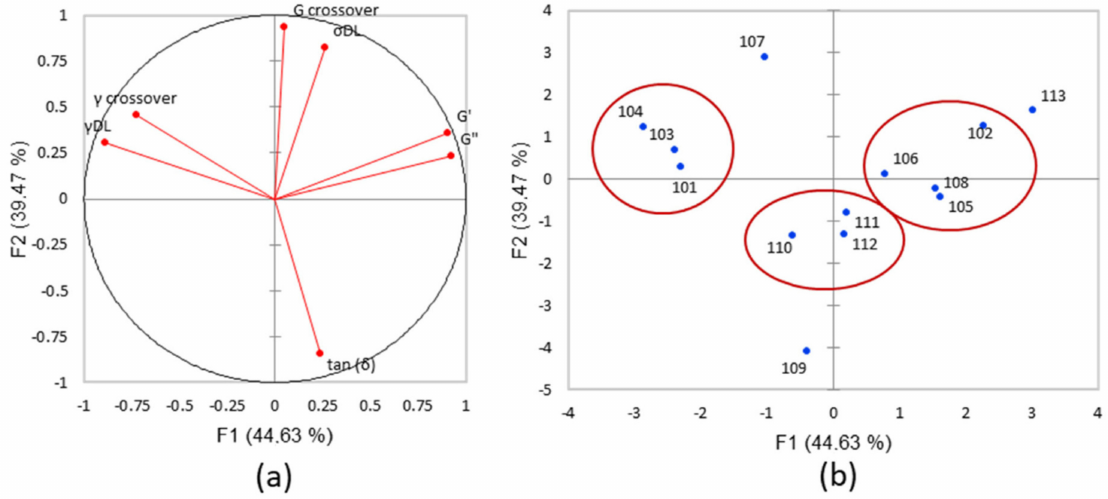
Figure 5. ( a ) PCA plot of the rheological parameters (variables) and ( b ) scatter plot of the products (individuals) for the oscillation strain test (PC1 44.63%, PC2 39.47%).